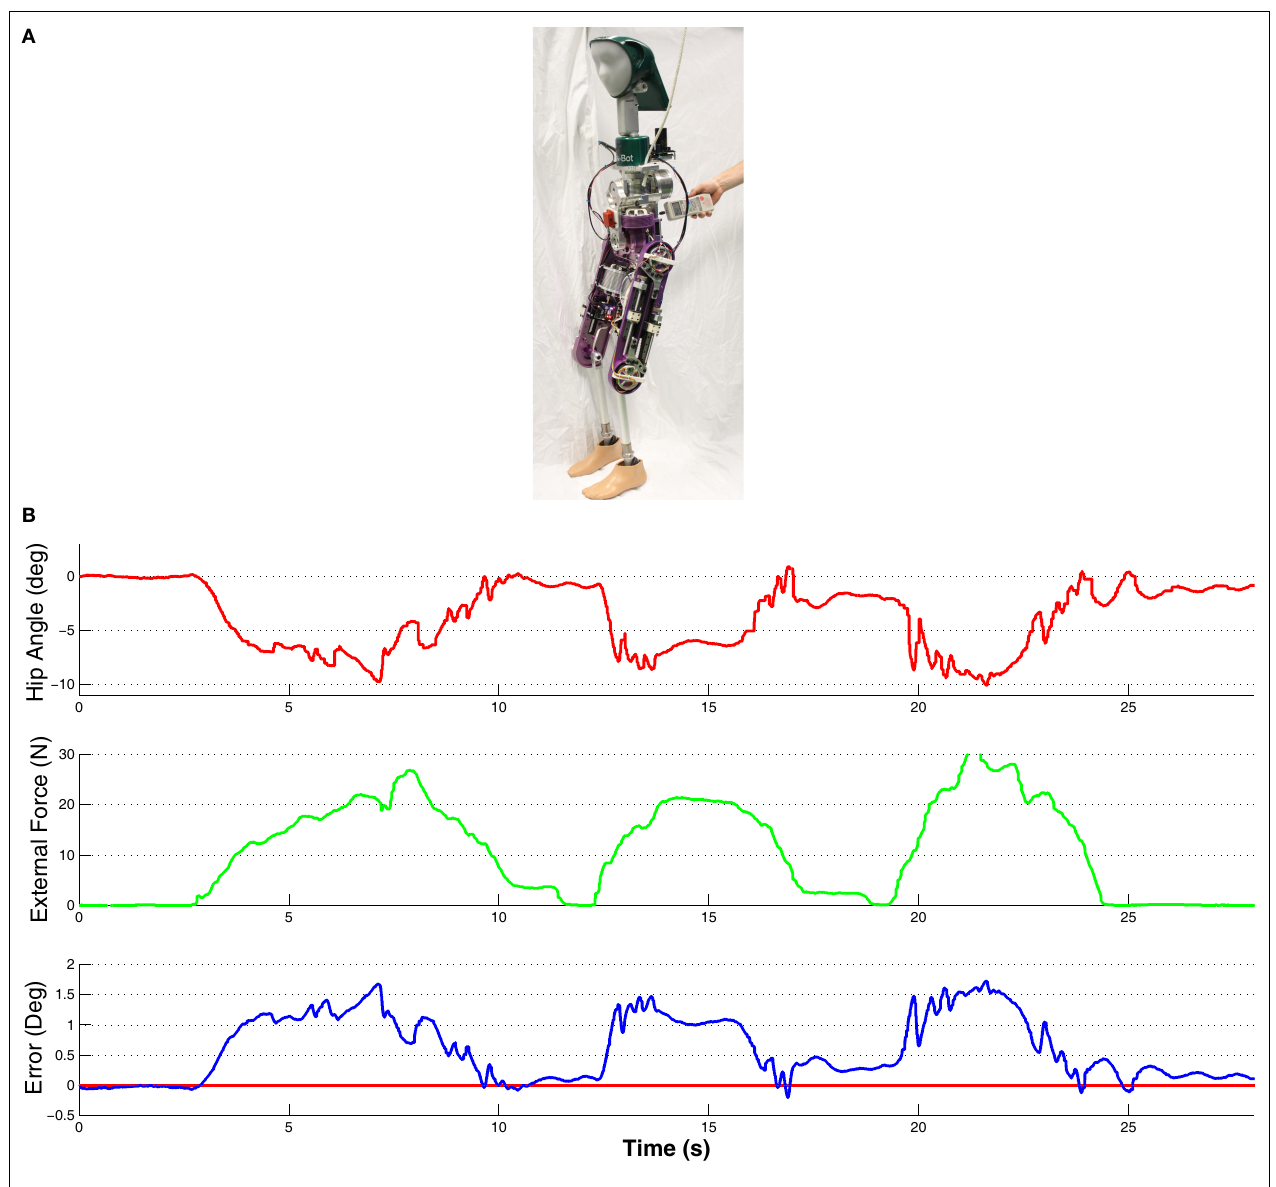
FIGURE 15 | (A) Herbert balancing when an external force of 25.6N is applied and with no external support in any plane. (B) . Graph of Herbert balancing when an external force is applied. This shows Herbert moving his hip to keep his CoM over his feet when an external force is applied to him.